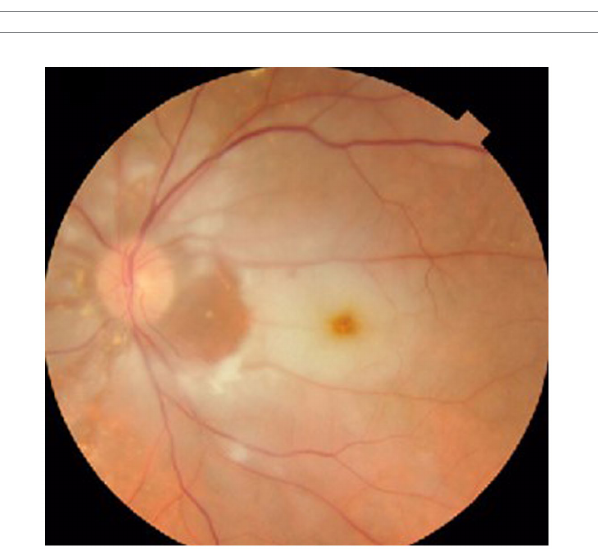
FIGURE 11 Appearance of the 28 years old patient presented in the ER with CRAO in the left eye.